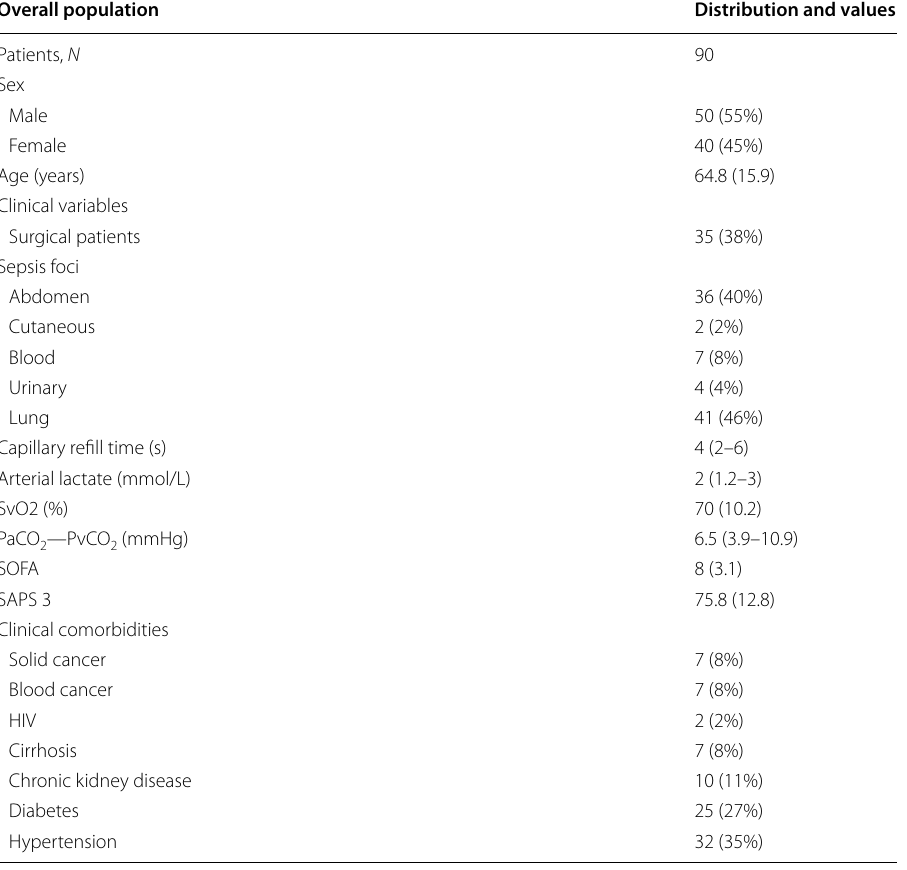
Data are N (%), mean (SD), or median (IQR). SOFA sequential organ failure assessment, SAPS 3 simplified acute physiology score 3